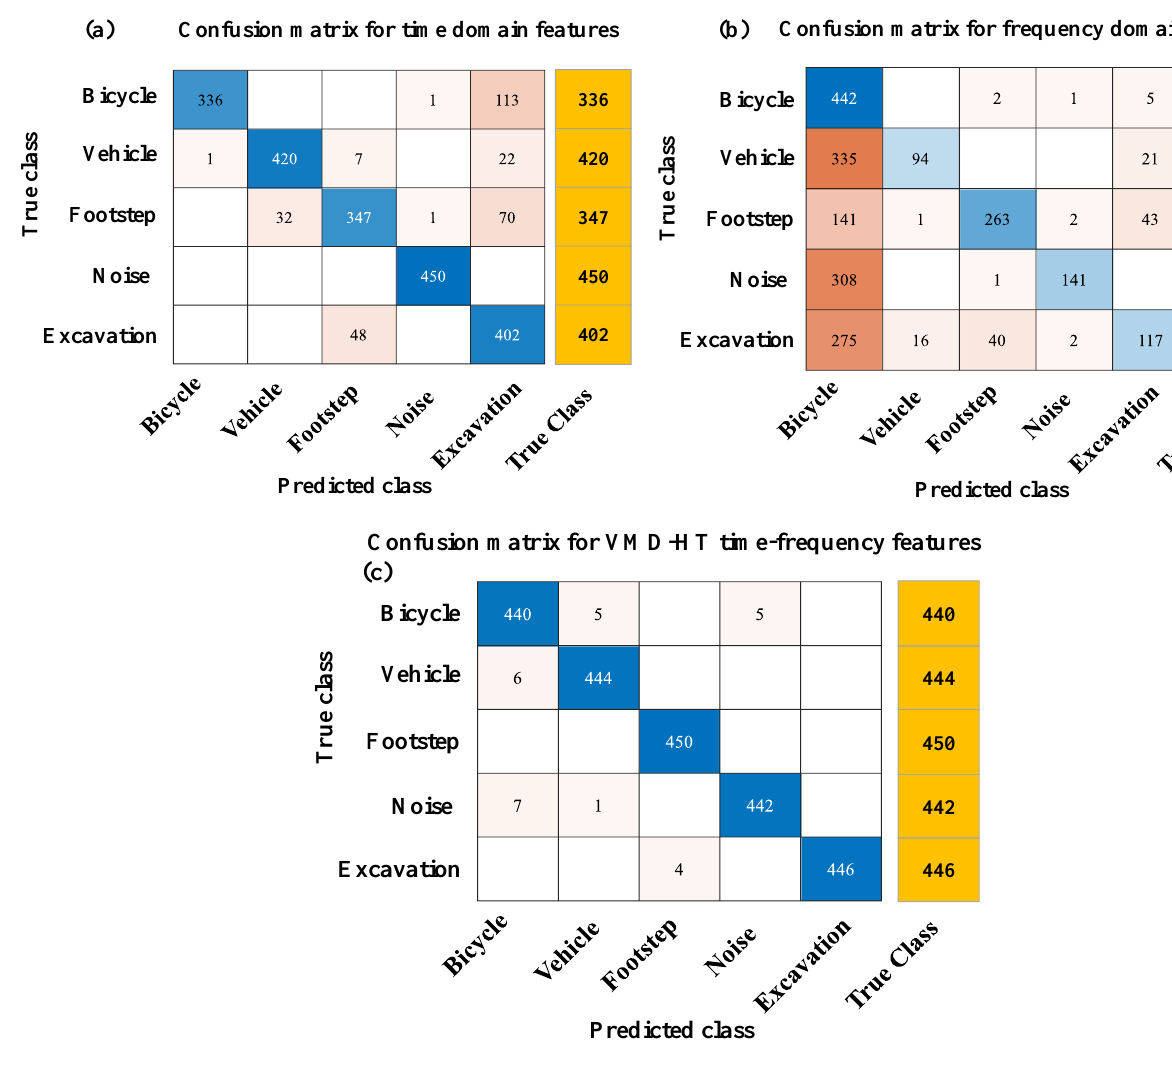
Figure 6. The confusion matrices obtained from feature testing sets generated in different domains.